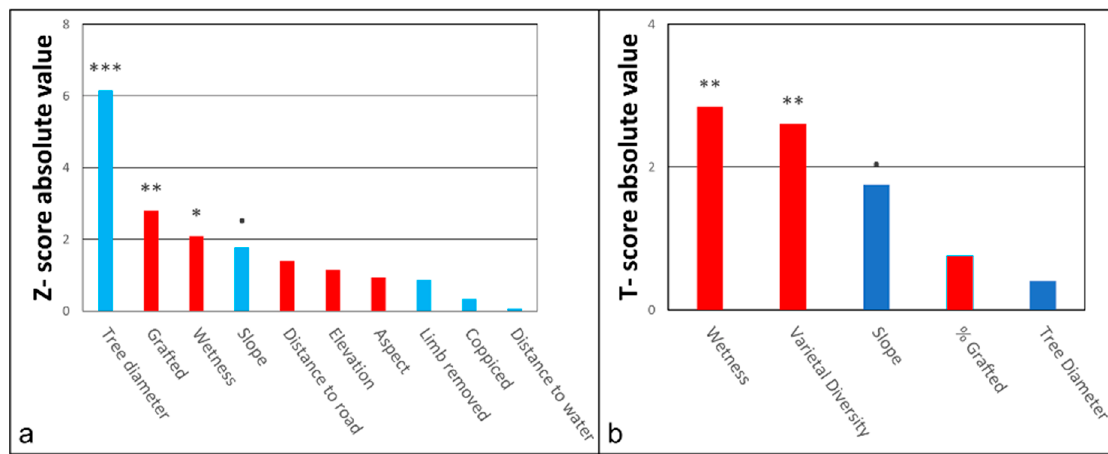
Figure 4. ( a ) Effect size of all factors on disease severity for trees as represented by absolute value of z-score generated by GLMM; ( b ) Effect size of significant factors on median plot disease severity as represented by absolute value of t-score generated by LMM. Lighter color indicates a positive correlation and darker, a negative correlation. For both charts, significance indicated as *** representing 0, ** representing 0.001, * representing 0.01, and • representing 0.05.